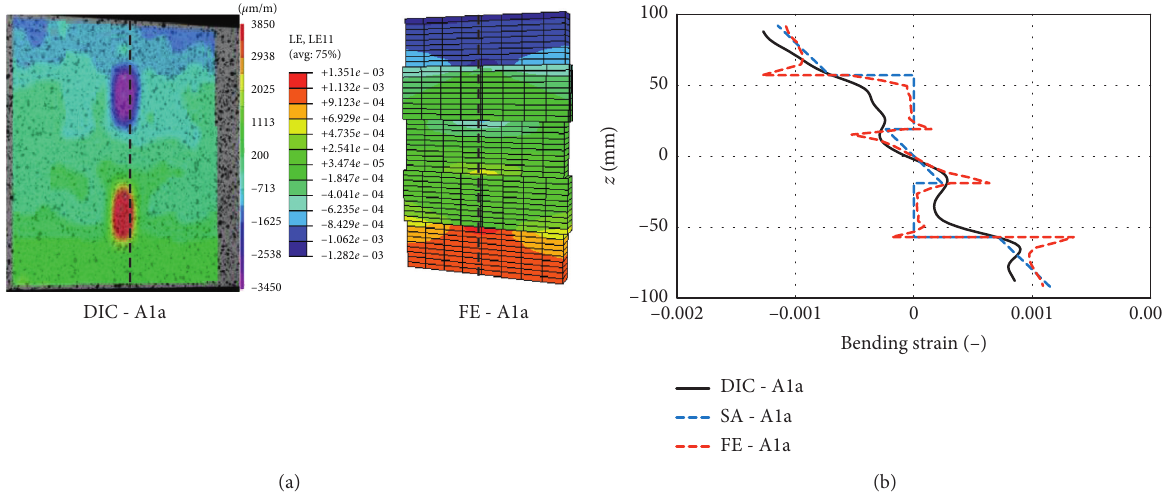
Figure 16: Colour contour plots and normal strain distribution from bending tests for A1a.